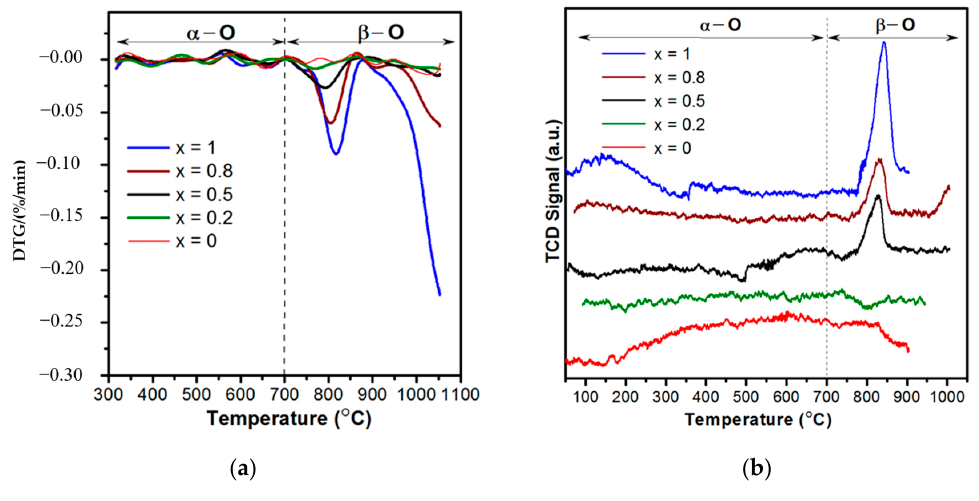
Figure 4. ( a ) STA; ( b ) TPD-O 2 curves of GdFe 1 − x Co x O 3 .